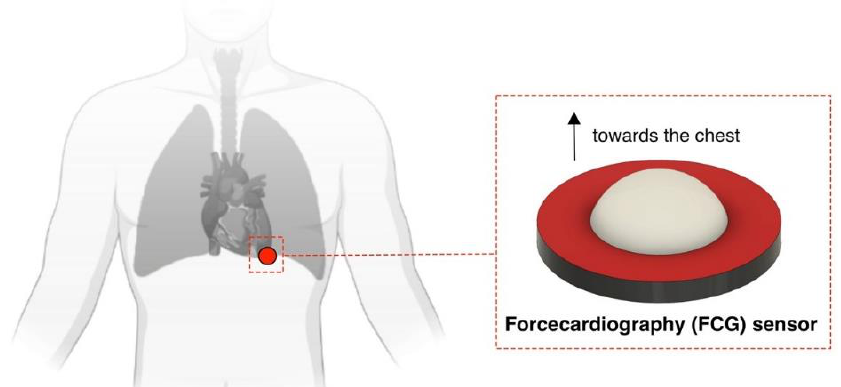
Figure 1. Piezoelectric FCG sensor placement on a subject. Reproduced with permission from [ Er- ror! Reference source not found. ].